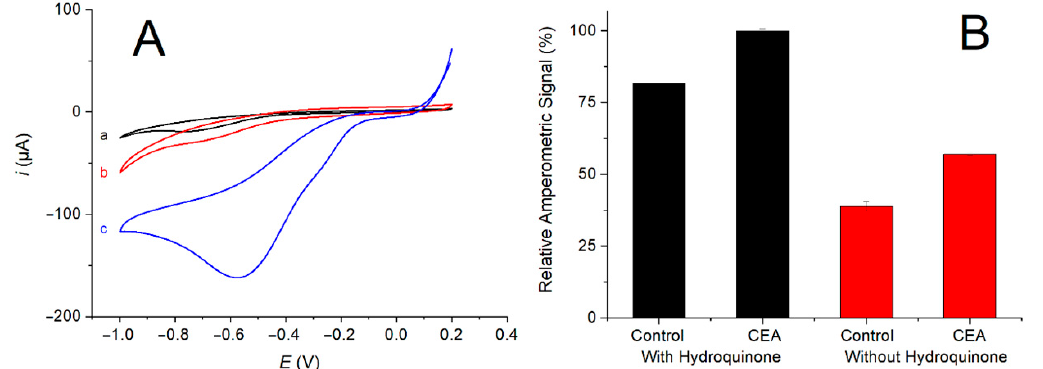
Figure 2. ( A ) Cyclic voltammograms for SPE at 50 mV/s in 50 mM H 2 O 2 , 0.1 M sodium phosphate buffer, pH 7.4, before ( a ) and after sequential modification with GO ( b ) and AuNF ( c ). ( B ) Relative amperometric response for the aptasensor after sequential incubation with 20 pg/mL CEA and HRP-CD and measured in the absence and the presence of 1.0 mM hydroquinone.